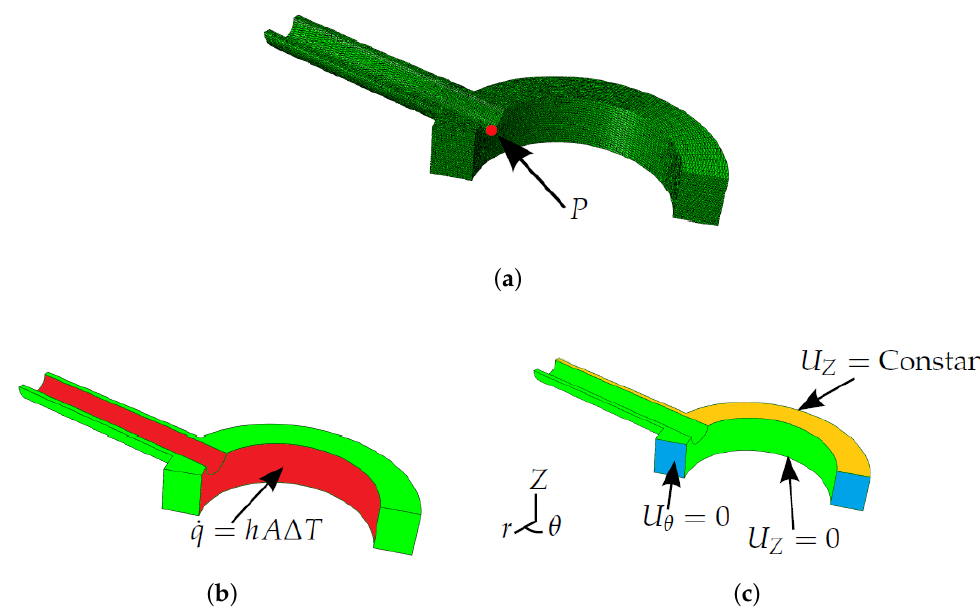
Figure 1. Finite element analysis (FEA) models, showing: ( a ) the tetrahedral mesh, exploiting the plane of symmetry between stub penetrations and showing the location of the example point of interest P ; ( b ) boundary conditions in the thermal analyses; and ( c ) boundary conditions in the mechanical